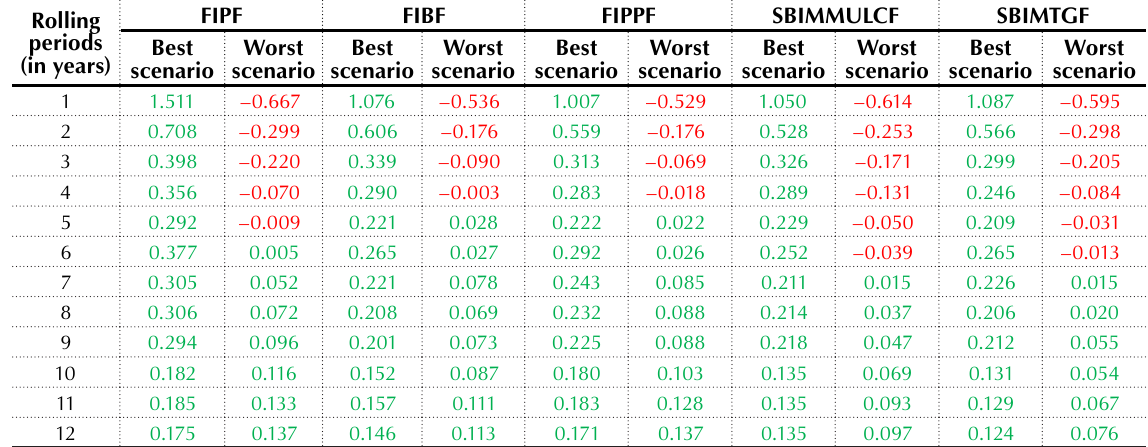
Table 9. Rolling period CAGR (in %) for FIPF, FIBF, FIPPF, SBIMMULCF, SBIMTGF schemes (from 2006 to 2018)